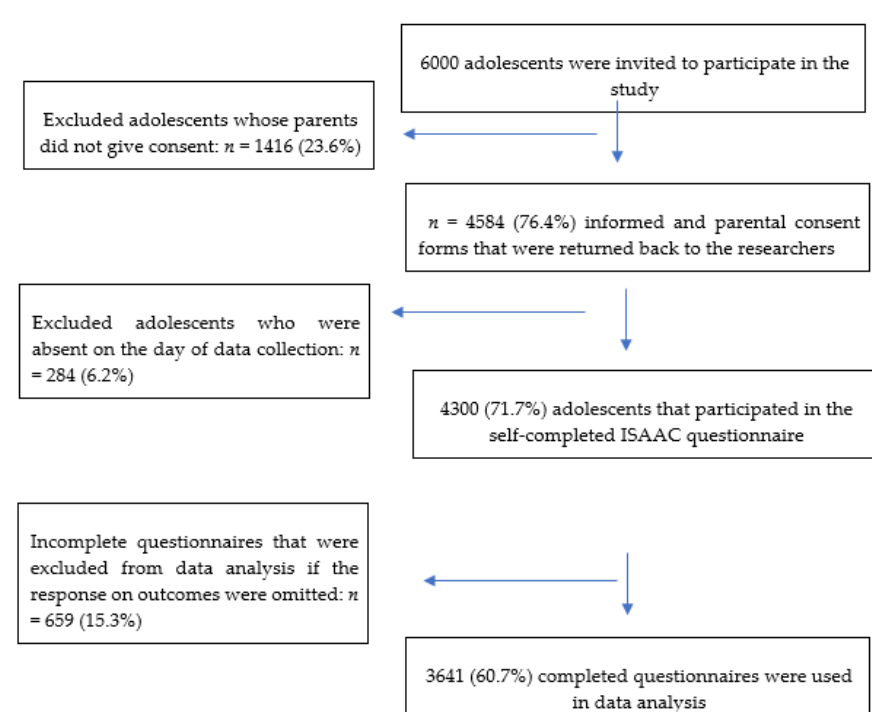
Figure 1. Recruitment procedure of study participants and participation rate.